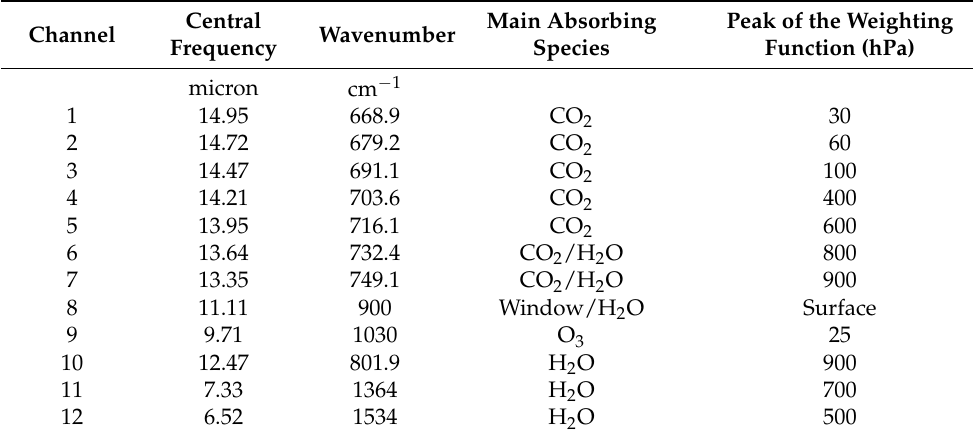
Table 1. HIRS channel spectral characteristics used in the present